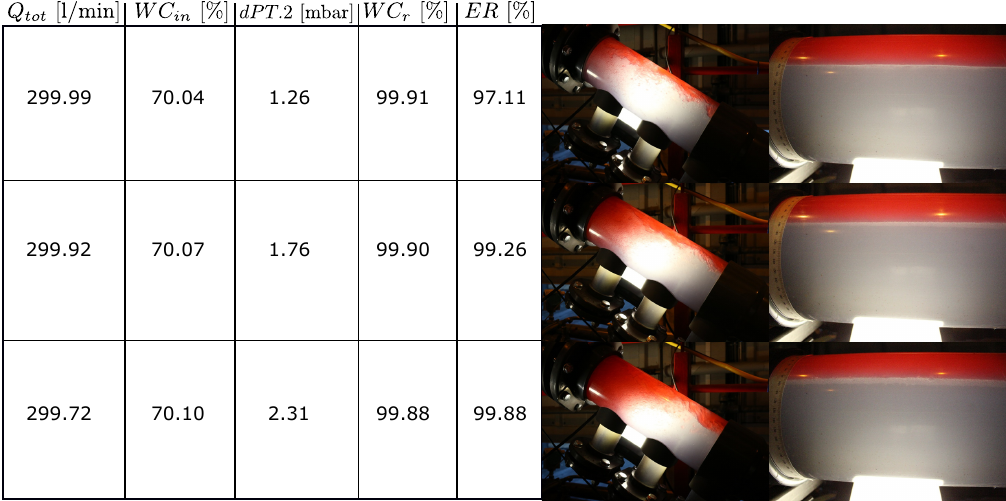
Figure A2. 300 L/min inlet flow and 70% water cut.